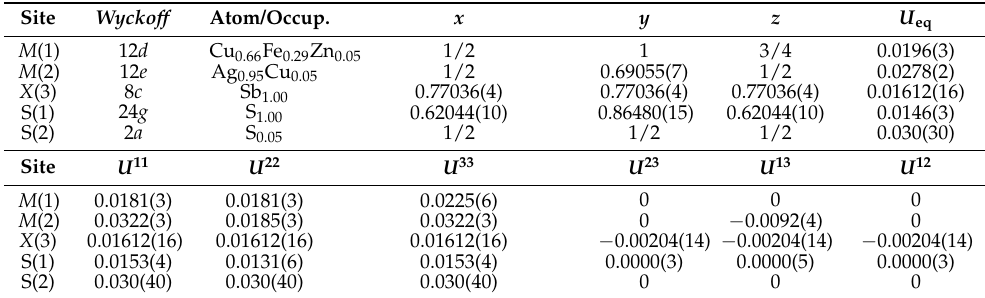
Table 3. Fractional atomic coordinates and displacement parameters (Å 2 ) of atoms in kenoargentotetrahedrite-(Fe) from